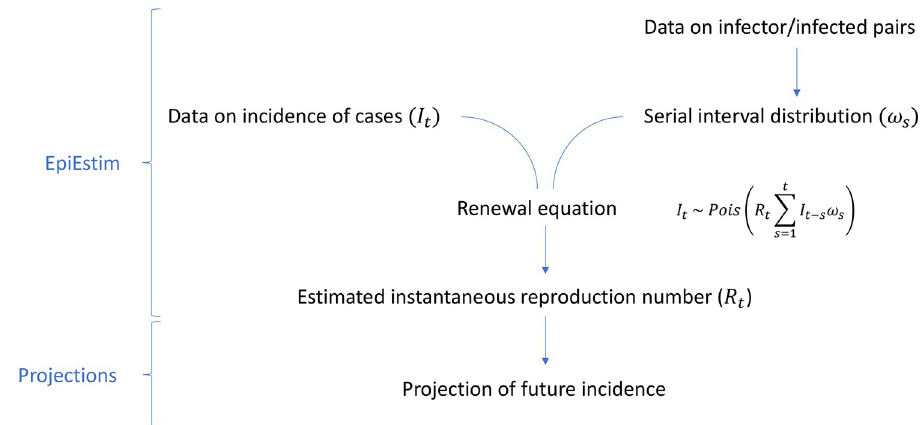
Fig 1. Schematic of the forecasting process. In the renewal equation, the incidence at time t (I t ) is expressed as a function of the serial interval distribution ( ω s ), the time-varying reproduction number (R t ) and the past incidence (I t-s ).